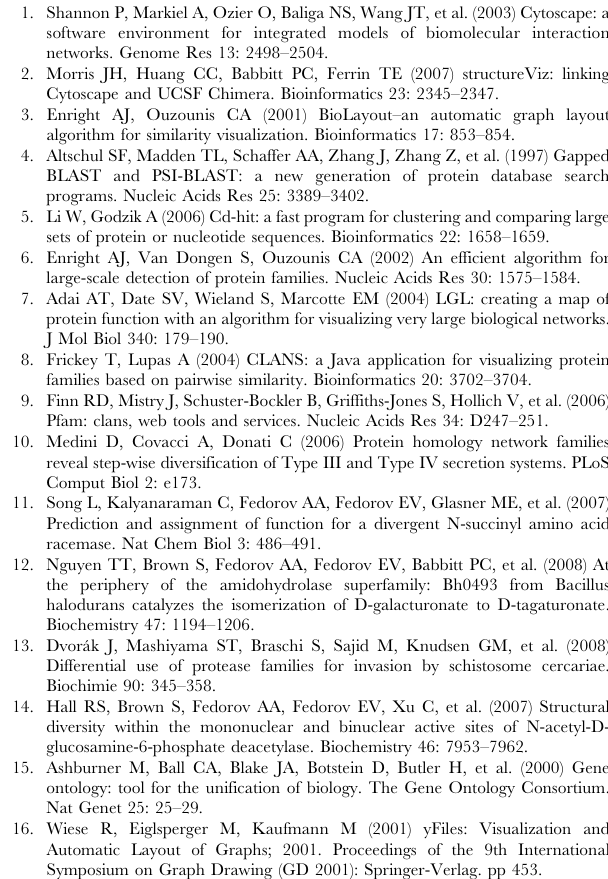
Table S2 Comparison of mathematically ideal and displayed pairwise network distances between 51 human STE and WNK kinases Table S3 Comparison of mathematically ideal and displayed pairwise distances between networks of the crotonase superfamily, using either full-length sequences or just the crotonase domain Found at: doi:10.1371/journal.pone.0004345.s003 (0.03 MB Figure S1 Network distances are similar between the Organic and Cytoscape force-directed layout weighted by E-value Found at: doi:10.1371/journal.pone.0004345.s004 (2.13 MB Figure S2 Comparison of network layout and clustering with BLASTCLUST Found at: doi:10.1371/journal.pone.0004345.s005 (3.85 MB Figure S3 Graphic showing how network topology is affected by missing data. The correlation is high between the topology of the Class A GPCR network and networks with 20% of the sequences removed at random.